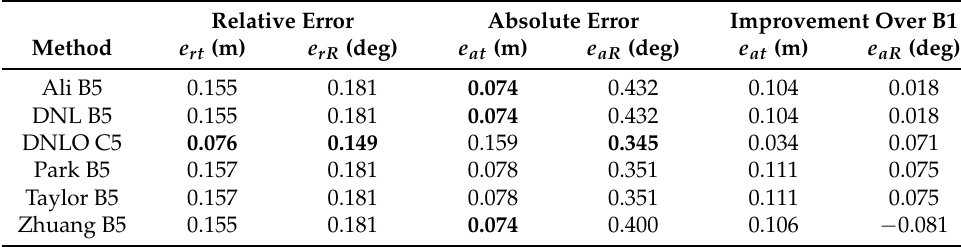
Table 2. Camera to camera calibration on KITTI 2011_10_03_drive_0027 . Relative Error Absolute